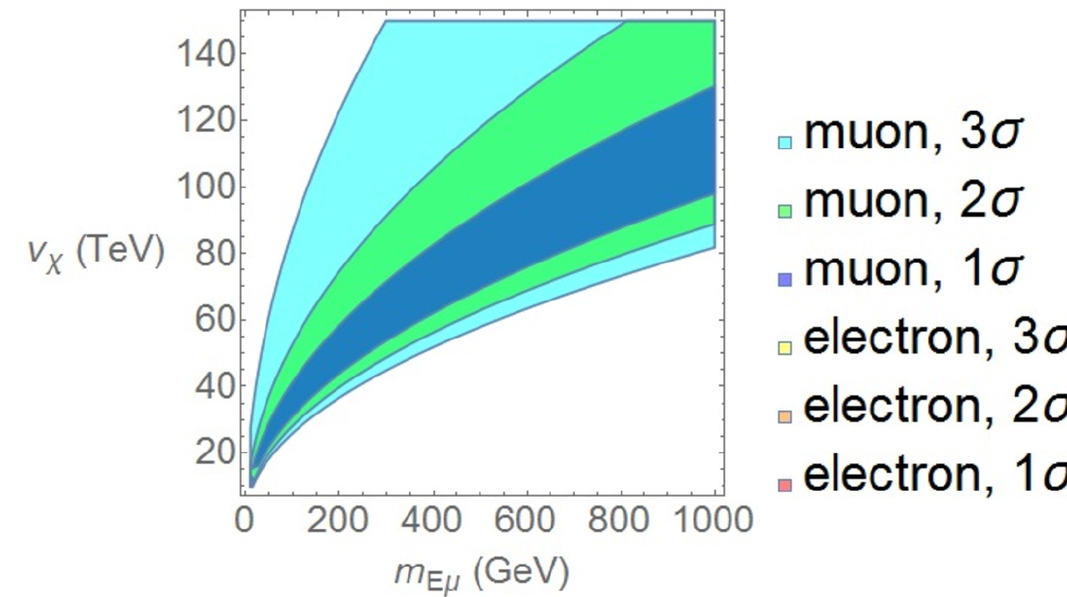
Figure 4 . Same as in (cid:12)gure 3 but now with m E